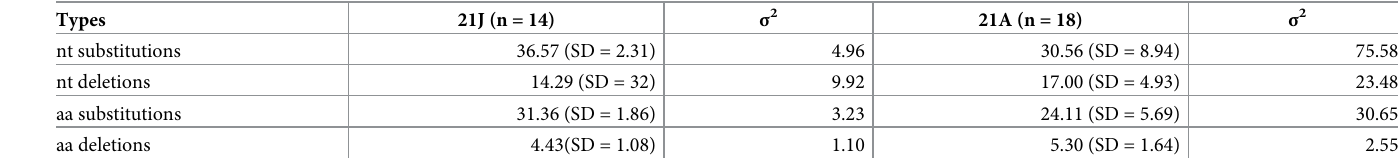
Table 8. Sample mean values of nucleotide and amino acid mutation type between the subclades 21A and 21J. Types